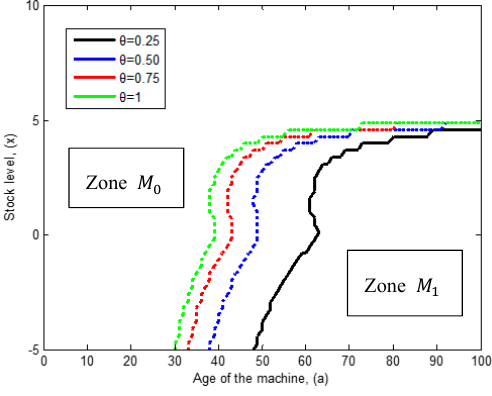
Figure 15. Sensitivity of the pace of the failure rate on the repair/major maintenance policy.